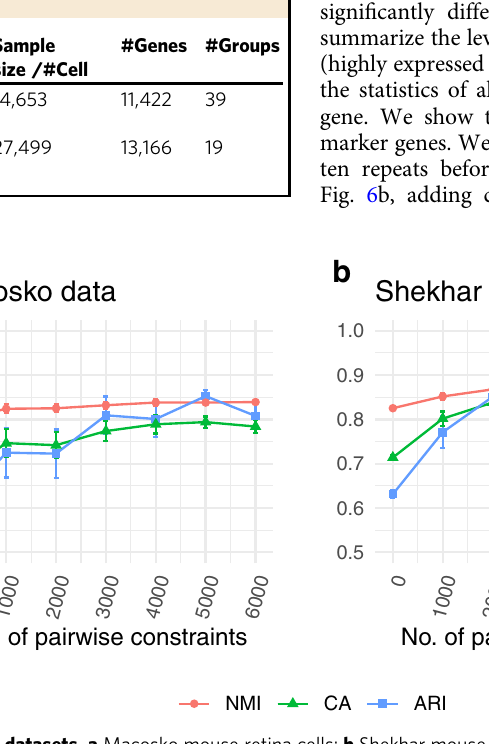
Fig. 4 Performances of scDCC on large datasets. a Macosko mouse retina cells; b Shekhar mouse retina cells. Clustering performances of scDCC on two large scRNA-seq datasets with different numbers of pairwise constraints, measured by NMI, CA, and ARI. All experiments are repeated ten times, and the means and standard errors are